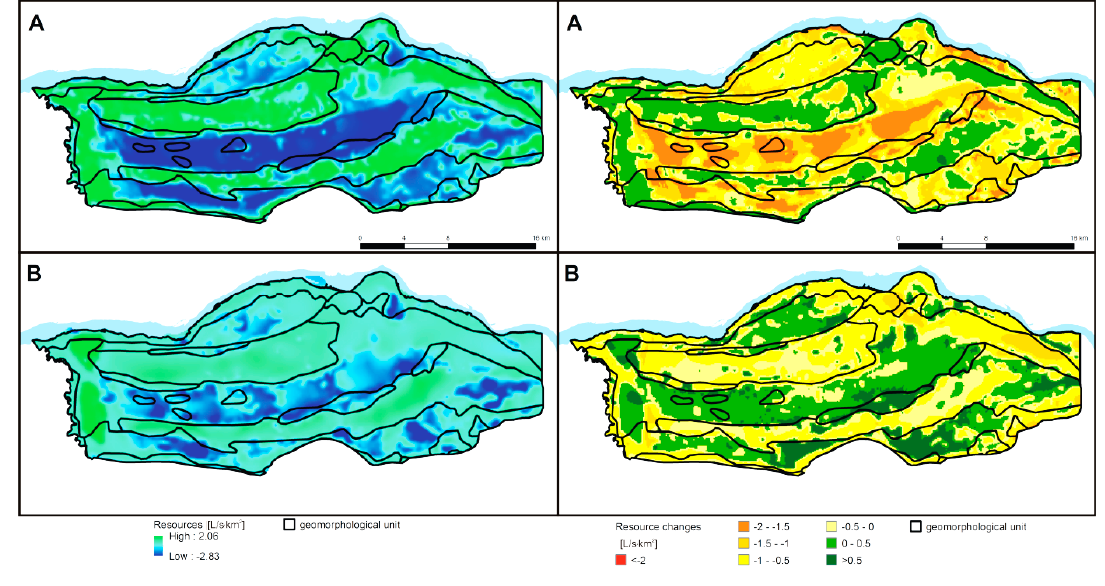
Figure 10. Renewable resources and their changes according to steady state: ( A ): variant 2; ( B ): variant 3.